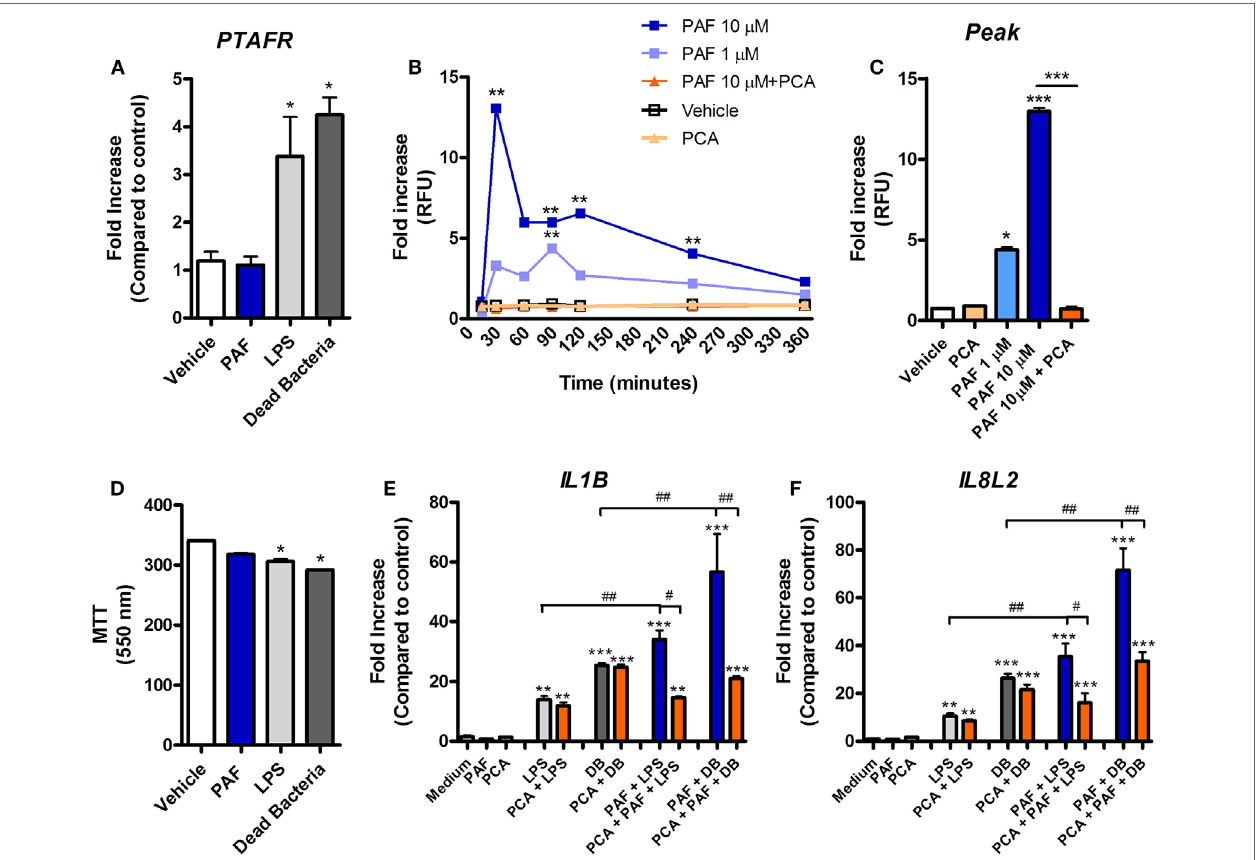
FigUre 9 | Exogenous platelet-activating factor (PAF) contributes to chicken endothelial cell dysfunction and increased pro-inflammatory response to bacteria- associated molecular patterns. (a) PAF receptor (PAFR)/ PTAFR gene expression, as evaluated by quantitative real-time PCR (qRT-PCR) analysis, in chicken aortic endothelial cells (chAEC) from PA12 outbred chickens following treatment with PAF (10 µM), lipopolysaccharide (LPS) (10 ng/ml), or dead bacteria (DB, 10 multiplicity of infection) for 6 h. (b) Fluorescein isothiocyanate (FITC)-dextran relative fluorescence units (RFU), as an index of chAEC monolayer permeability in a transwell system, following treatment with PAF (1 or 10 µM) in the presence or absence of PCA 4248 (10 µM). (c) FITC-dextran RFU in the same transwell system at 30 min post chAEC treatment with PAF in the presence or absence of PCA 4248. Data are expressed as fold increase as compared to vehicle control group. (D) chAEC viability, as evaluated through a colorimetric assay based on methylthiazoletetrazolium bromide cellular metabolism, following treatment with PAF, LPS, or DB for 6 h. Data are expressed in optical density at 550 nm. (e) IL-1 β / IL1B and (F) CXCLi2/ IL8L2 gene expression in chAEC following treatment with PAF, LPS, and DB for 6 h in the presence or absence of PCA 4248. qRT-PCR data are expressed as relative normalized expression (as compared to vehicle control group). Values are mean ± SEM. * P < 0.05, ** P < 0.01, and *** P < 0.001 when compared to negative (vehicle) control groups. # P < 0.05, ## P < 0.01, and ### P < 0.001 when compared to positive control